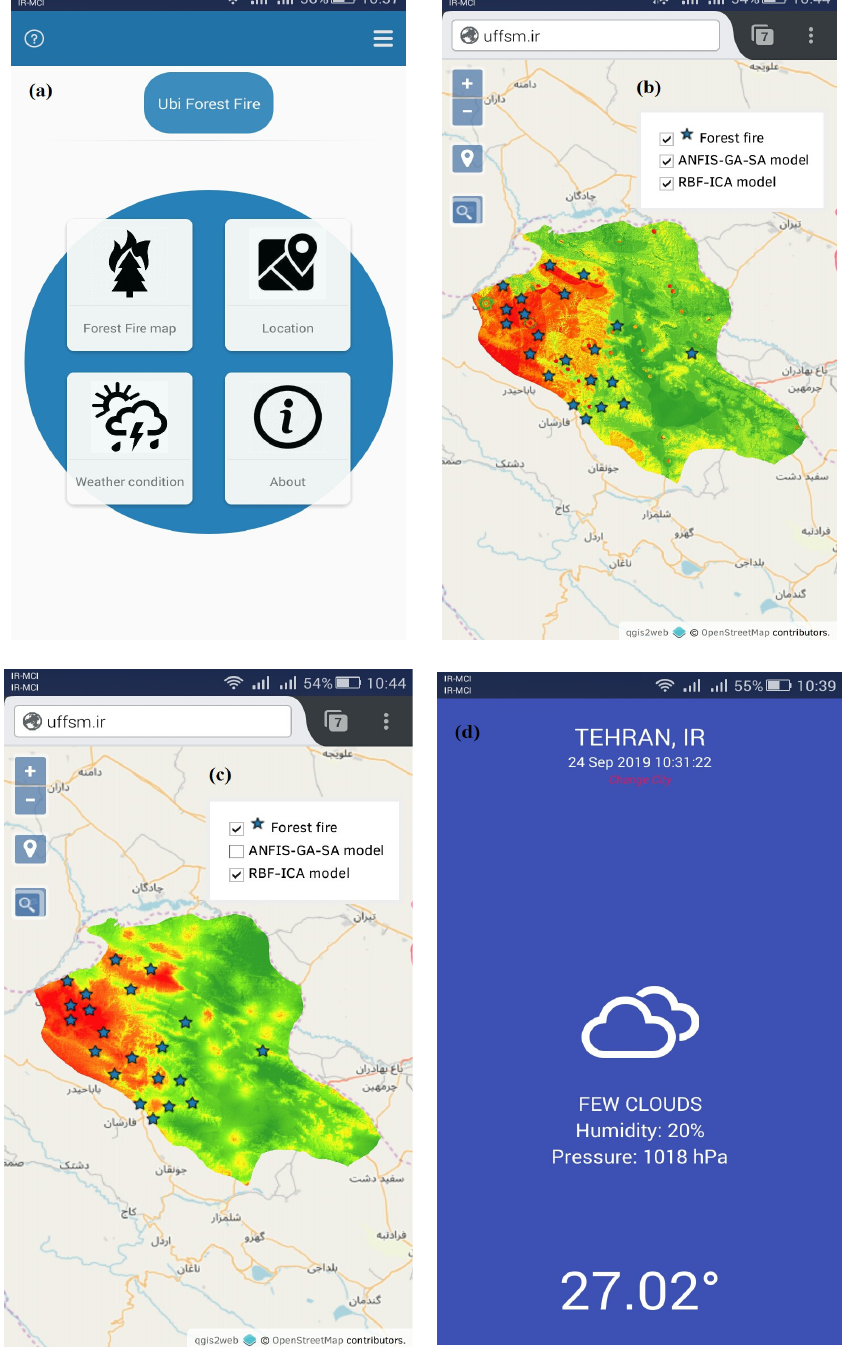
Figure 15. Mobile application developed: a) Main menu b) Result of ANFIS-GA-SA c) Result of RBF-ICA d) Weather condition.